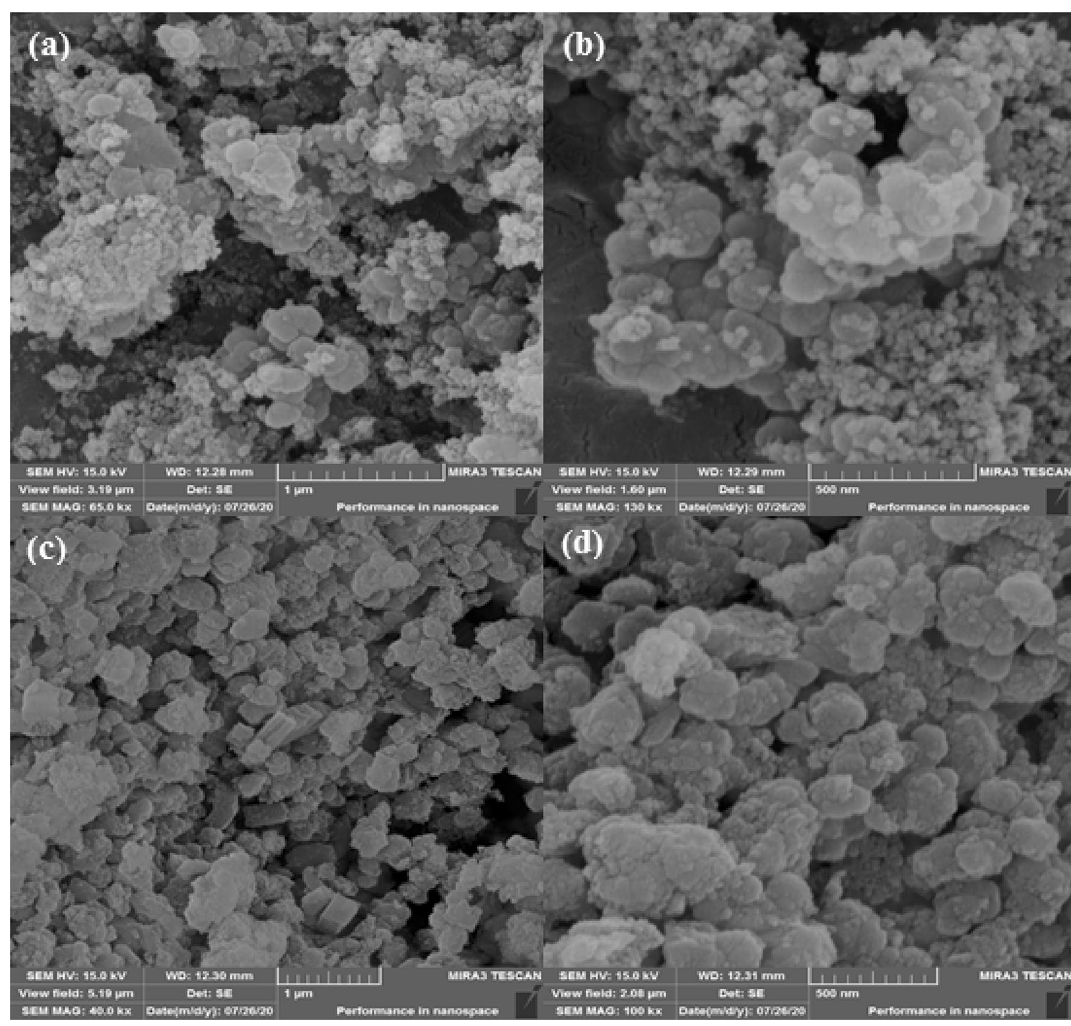
Figure 3. SEM images of UiO-66-NH 2 ( a , b ); and UiO-66-biguanidine/Pd nanocomposite ( c , d